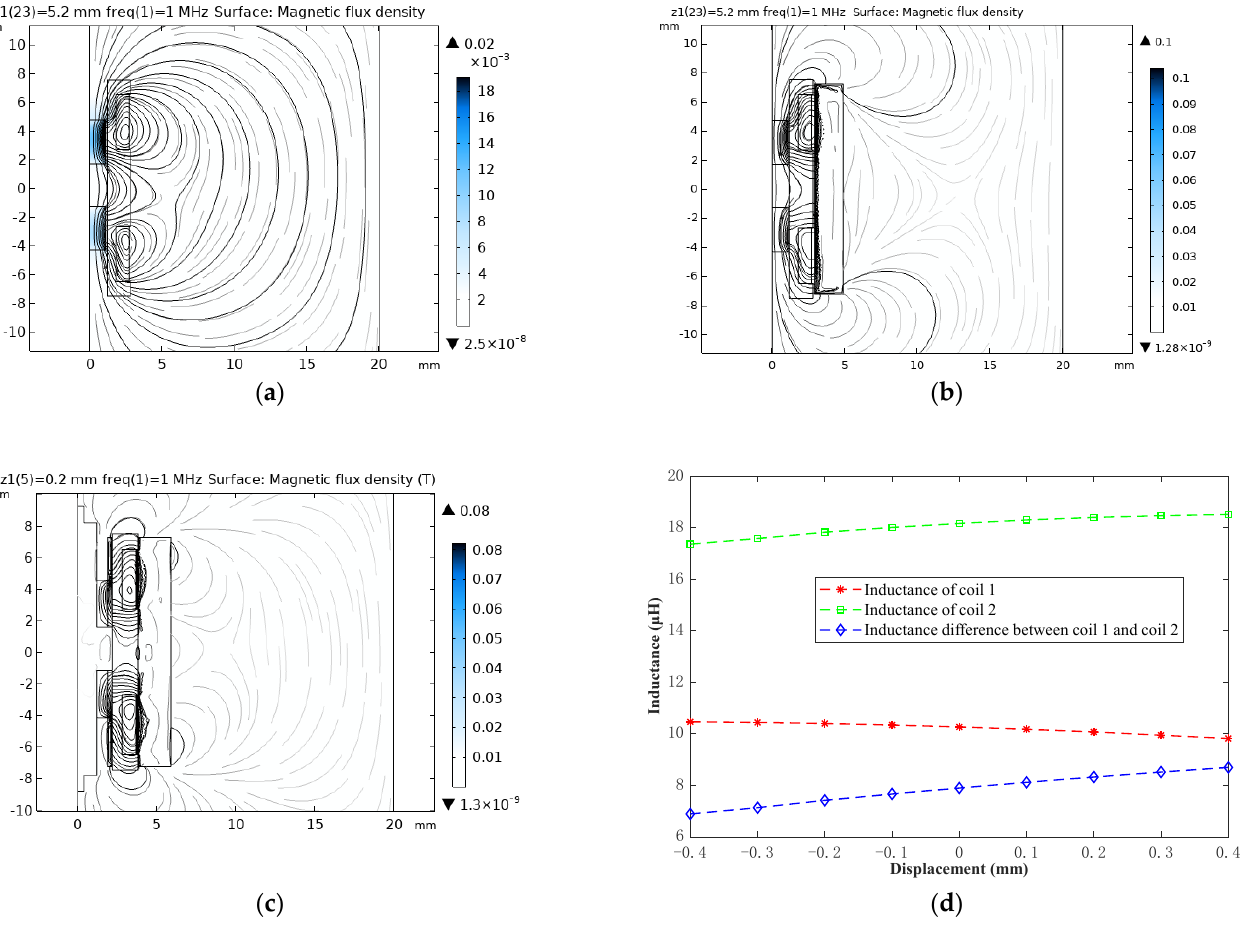
Figure 3. Finite element simulation results of the DIFOD sensor: ( a ) Magnetic flux density distribution (not using a magnetic shield ring and the copper bush); ( b ) Magnetic flux density distribution (only using magnetic shield ring); ( c ) Magnetic flux density distribution (using magnetic shield ring and copper bush); ( d ) The relationship curve of the inductance of the differential coil with the displacement.